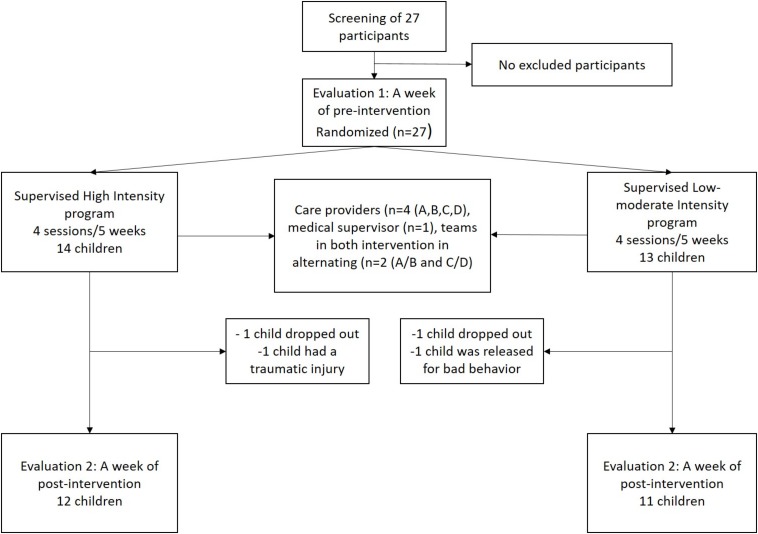
Flow chart of study design. Among the 27 pre-adolescents who were recruited and randomized (quantifiers: CDI, BMI, Léger shuttle test, age, sex, and school year), four participants were lost during the experimentation. The statistical analysis of T1 and T2 measures was restricted to the 23 participants involved in the whole study.